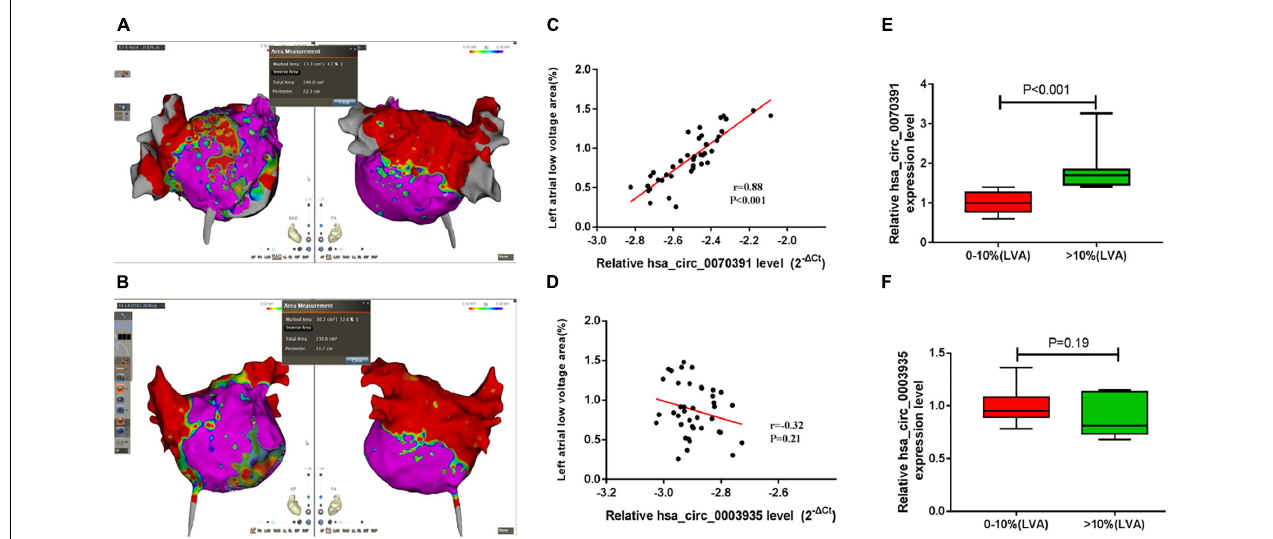
FIGURE 6 | The correlation between different circRNAs and left atrial fibrosis in persistent AF. (A,B) The representative image of the left atrial low voltage area (LVA), red color represented the LVA (local electrograms < 0.4 mV), which was used to estimate the severity of left atrial fibrosis, Purple color represented the normal substrate (local electrograms > 0.4 mV). (A) Showed the low voltage area was less than 10%, (B) showed the low voltage area was more than 10%. Anterior–posterior angle position (left) and posterior–anterior position were simultaneous displayed (right); (C) the association between plasma hsa_circ_0070391 and extent of left atrial low voltage area; (D) the association between plasma hsa_circ_0003935 and extent of left atrial low voltage area; (E) the hsa_circ_0070391 expression level in different extents of left atrial fibrosis; (F) the hsa_circ_0003935 expression level in different extents of left atrial fibrosis.